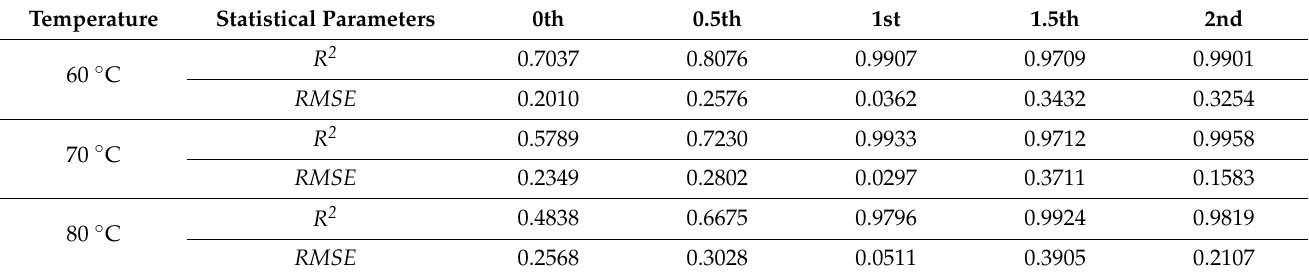
Table 5. Statistical parameters obtained from various orders of kinetic equation of β -carotene content. Temperature Statistical Parameters